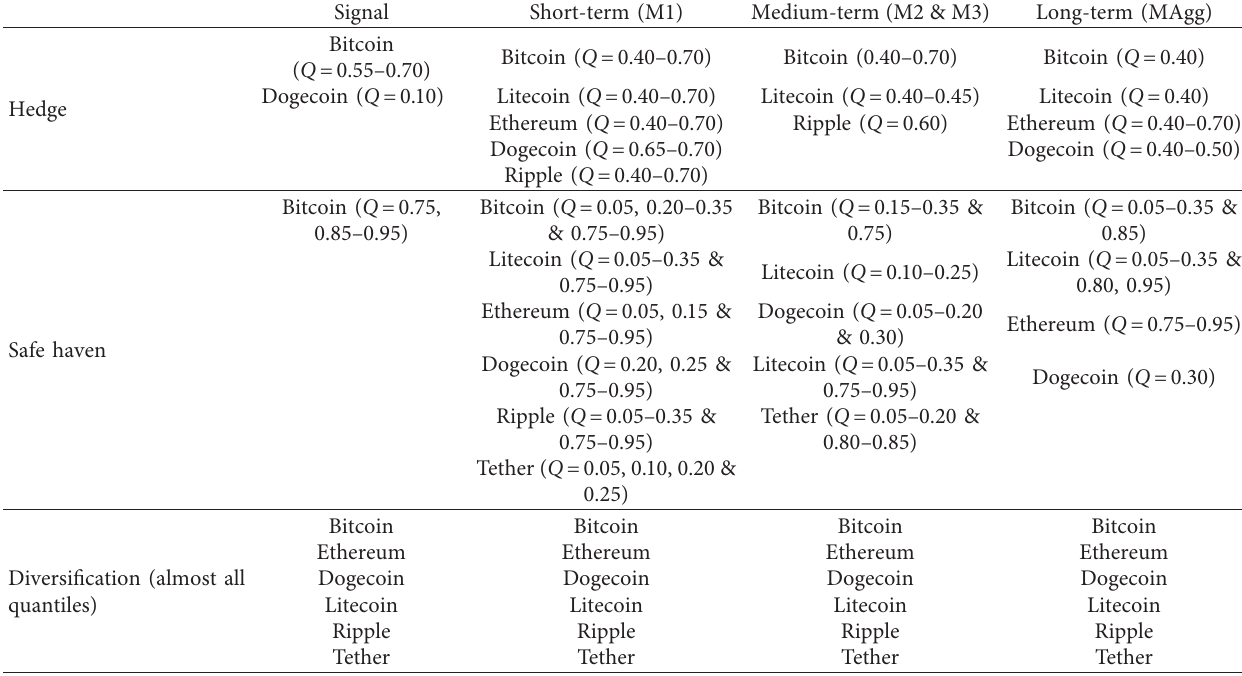
Table 8: Summary of frequency-dependent quantile regression result.